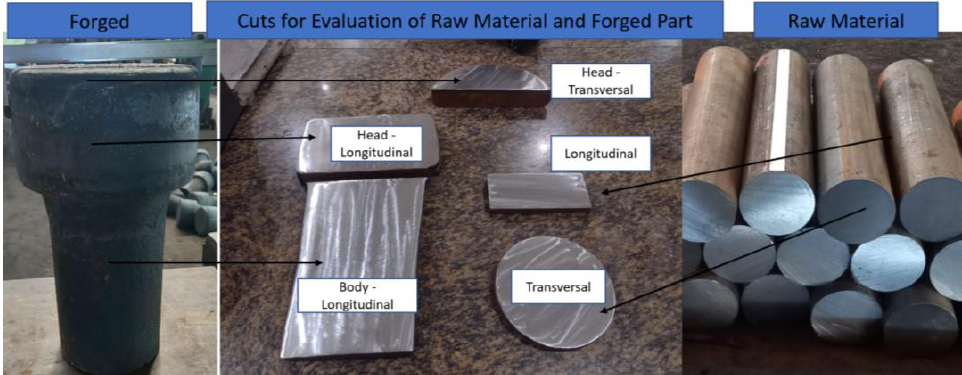
Figure 3. Dispositions of the cuts to metallography of raw material and forged